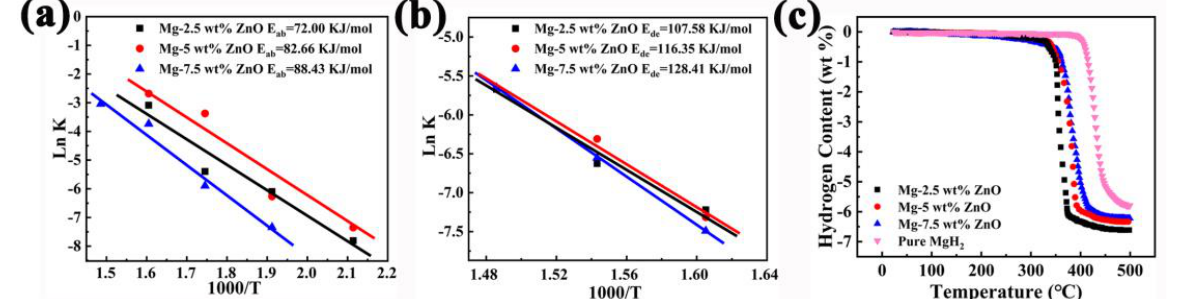
Figure 6. The lnk vs 1000/T plots of re-hydrogenated ( a ) and ( b ) dehydrogenated MgH 2 -xZnO, and the comparison of TPD curves ( c ).